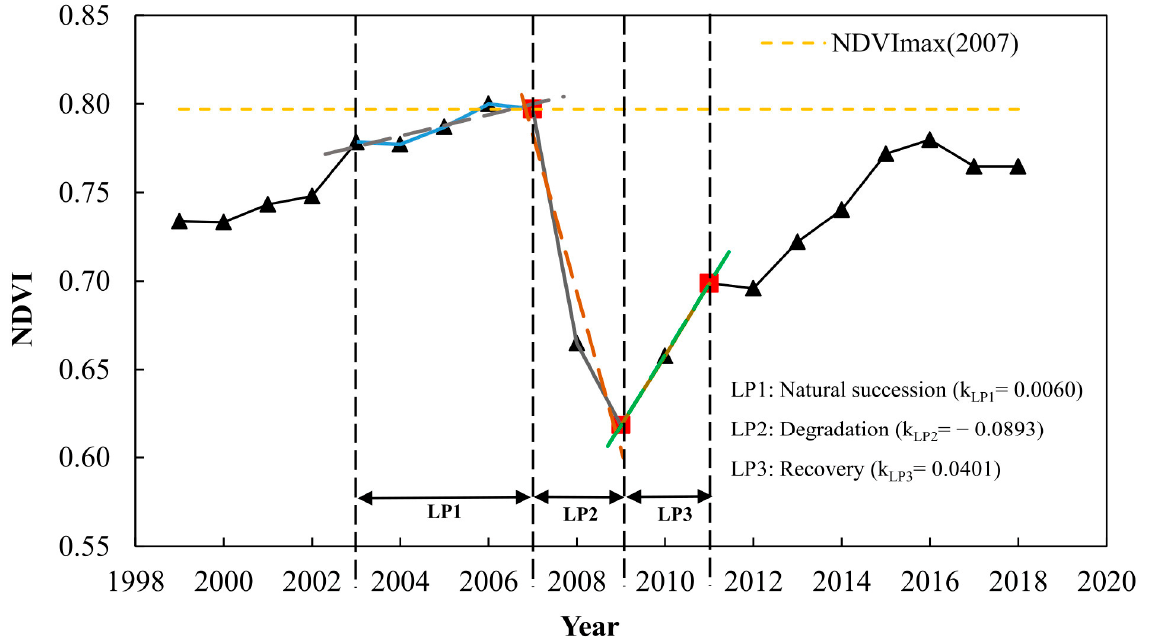
Figure 10. Interannual variation in NDVI in denuded areas (S ≥ 80,000 m 2 ). LP1, LP2, and LP3 rep- resent three periods of pre-earthquake natural succession, post-earthquake declines, and recovery of NDVI in the denuded (landslides) areas, respectively. The corresponding k refers to the slope of the NDVI linear fit within the period.